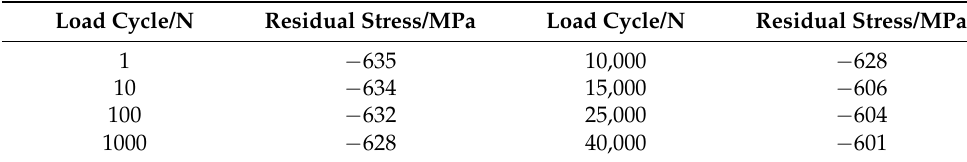
Table 2. The residual stress of specimen No. 1; specimen No. 1 was taken down after loading to a specific cycle, and the residual stress was measured. This operation was repeated until the specimen broke.